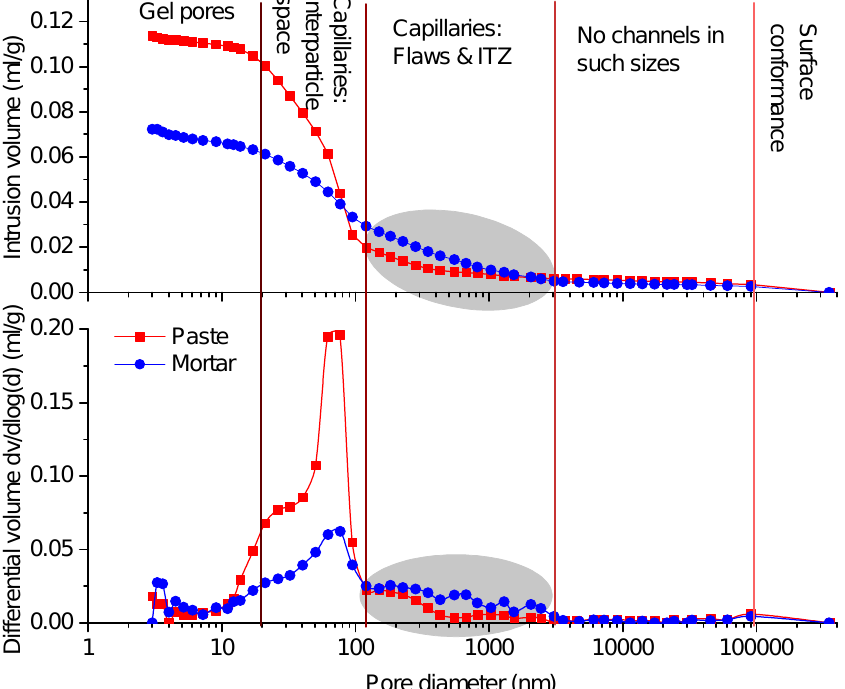
Figure 4. Accumulative ( top ) and differential ( bottom ) pore size distributions of paste and mortar samples (The specific contribution of ITZ in the mortar was singled out in the shadowed